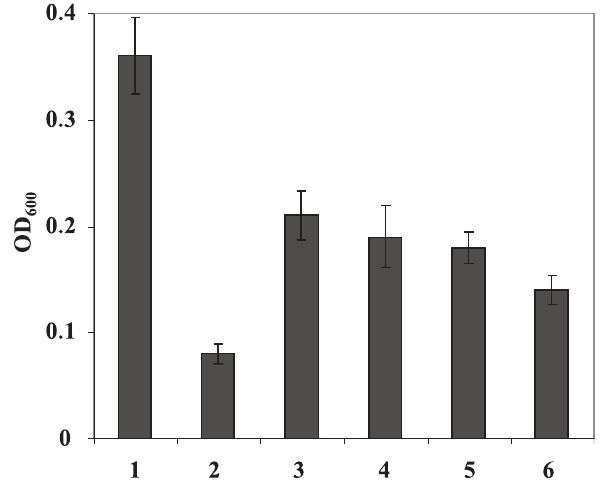
Figure 6. Levan production in Erwiniaamylovora wild type (WT), amyR mutant, complementation strain and WT containing pAmyR2. All strains were grown overnight in LB broth at 28 u C; 1 ml bacterial supernatant was mixed with equal volume of LS-buffer and incubated at 28 u C. After 24 h, the amount of levan was quantified at OD 600 and normalized to a cell density of 1. 1: Ea1189, 2: D amyR , 3: D amyR (pAmyR3), 4: D amyR (pAmyR2), 5: Ea1189 (pAmyR3), 6: Ea1189 (pAmyR2).